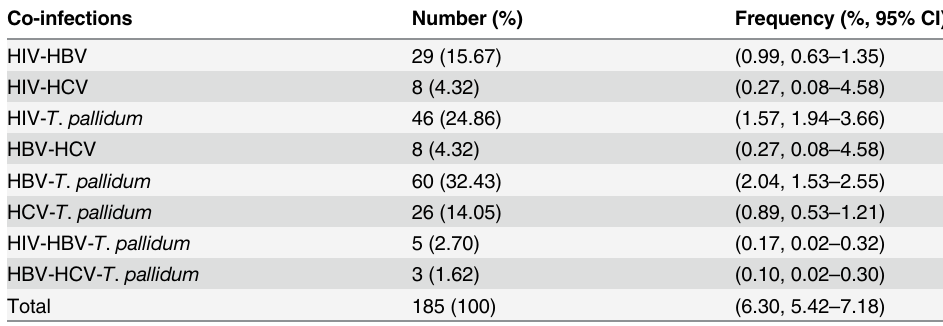
Table 2. The co-infection seroprevalence of HIV, HBV, HCV and Treponema pallidum among blood donors on Bioko Island, Equatorial Guinea, 2011 – 2013. Co-infections Number